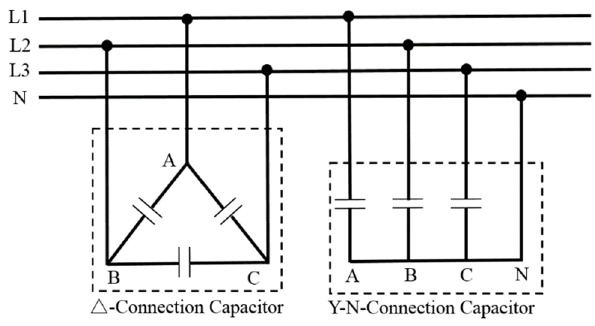
Figure 2. Connections of MFCs.